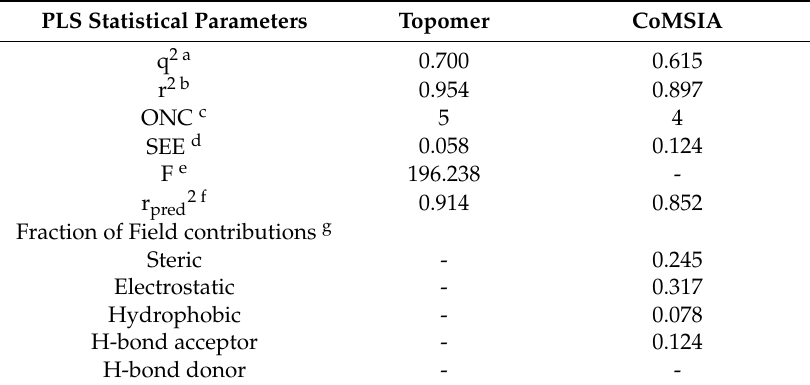
Figure 3. Experimental versus predicted activity of the training and test set based on the Topomer CoMFA model and CoMSIA model.